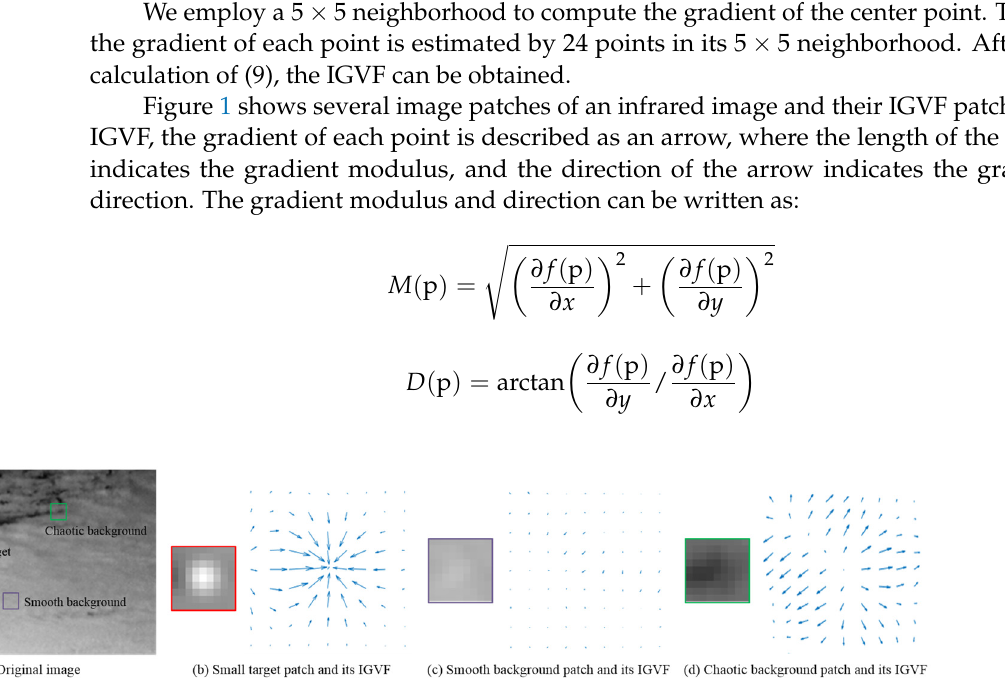
hind the imaging system, it can be seen that the length of the arrow at the small target is very long, which means that the modulus of the gradient at this point is large. In addi- tion, all arrows are pointing towards the center. However, the background IGVF patch does not have this obvious characteristic. For example, for the IGVF patch with the smooth background in Figure 1c, since the region is relatively flat, the gradient modulus in this region is very small. That is, the arrow length in the IGVF is very short, and the arrow direction is disordered. In the IGVF with the chaotic background of Figure 1d, although the length of the arrow is long, the directions of the arrows are chaotic and lack a clear pattern. Based on the above analysis, we believe that the IGVF patch of the small target has a unique gradient characteristic. That is, the gradient modulus at the target is very large, and the gradient directions all point towards the center. However, the gradient of back- ground clutter and chaotic noise does not have a clear pattern. For the chaotic back- ground patch in Figure 1d, the intensity of the background patch drastically changes and the contrast is obvious. If the LCM-based method is applied to detect small targets, it is easy to misdetect this patch as a small target area, resulting in a detection failure. How- ever, the gradient of the chaotic background patch is significantly different from that of the small target. Therefore, in our method, we detect small targets based on their unique gradient characteristics. 3.2. The Proposed MGCF Method Considering the scale changes caused by small targets are fast moving, different from the gradient correlation template proposed in [31], we designed a multi-scale gra- dient correlation (MGC) template, as shown in Figure 2. The MGC template consists of angles. In order to simulate the characteristic that the gradients of small targets all point towards the center, each angle in the MGC template also points towards the center. At